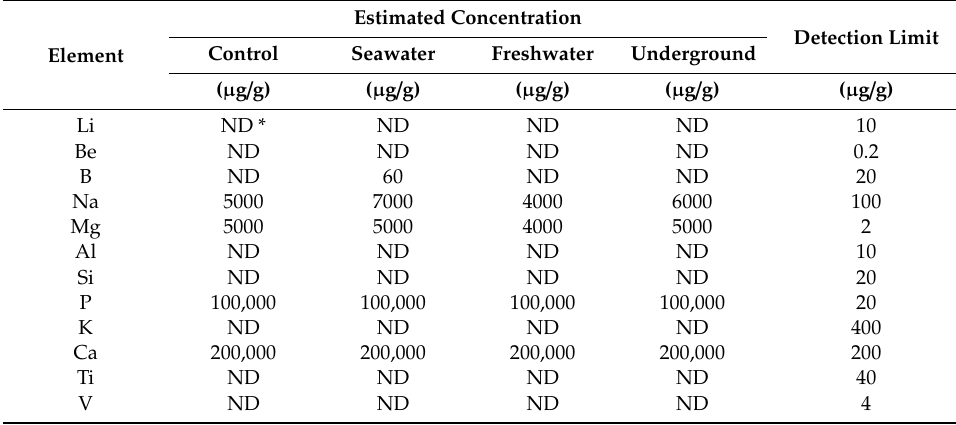
Table 2. Qualitative and semiquantitative analyses of 30 elements by ICP-OES. Estimated Element